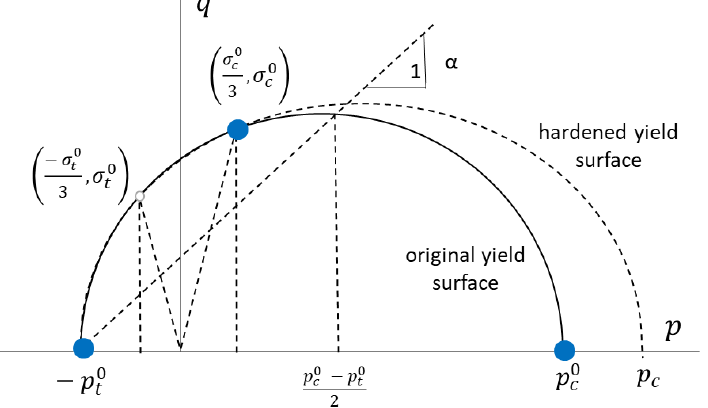
Figure 1. Ellipse in the meridional ( q – p ) stress plane of the crushable foam volumetric (CFV) model.